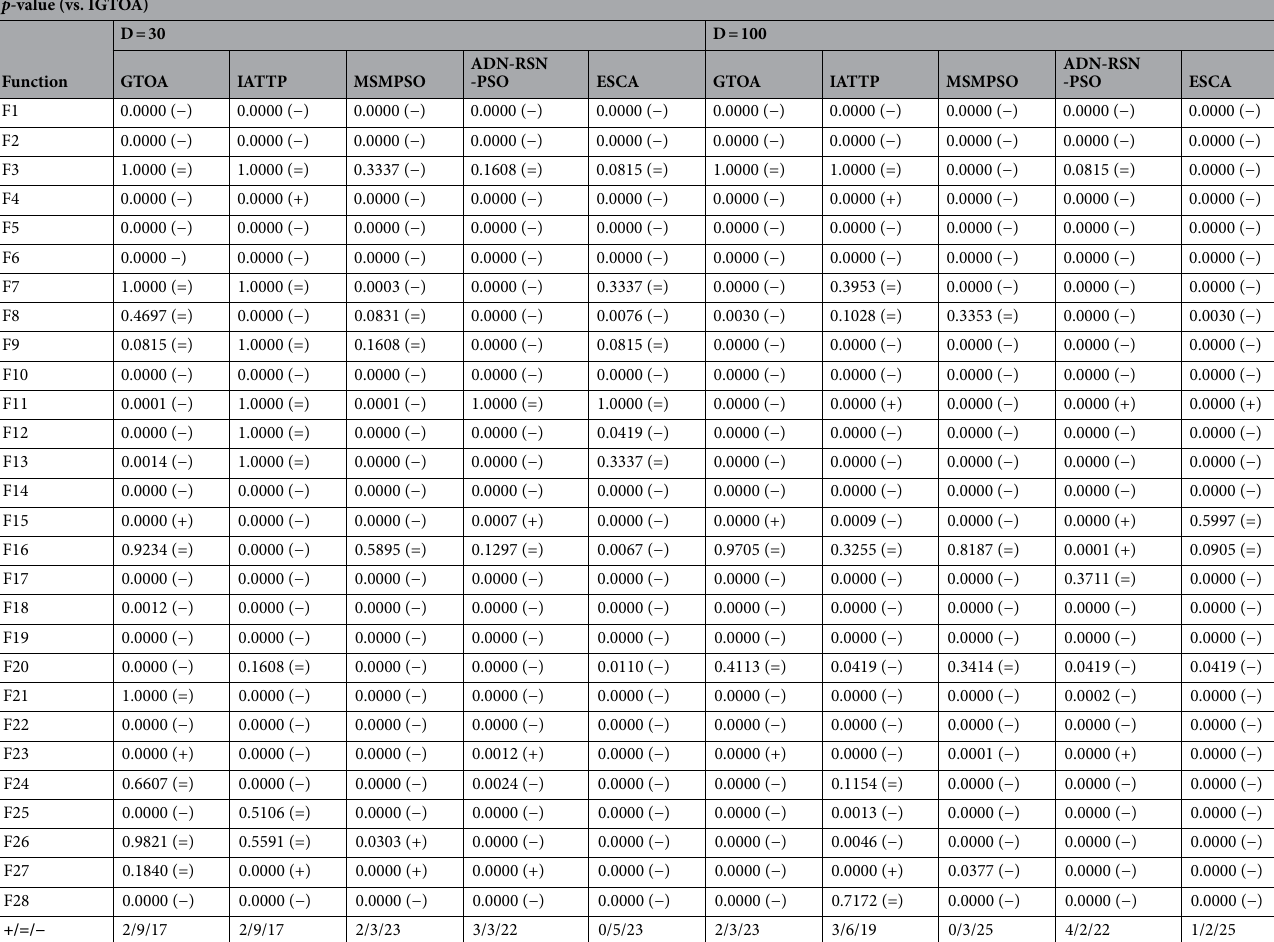
Table 7. Results of the Wilcoxon rank sum test by IGTOA with other algorithms.